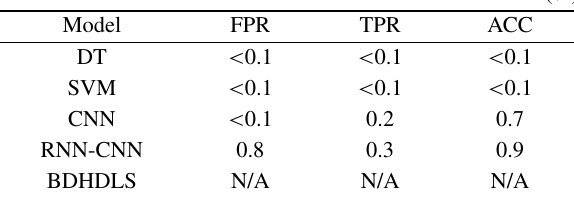
Table 4 “ p value by F test” for binary classification in the ISCX2012